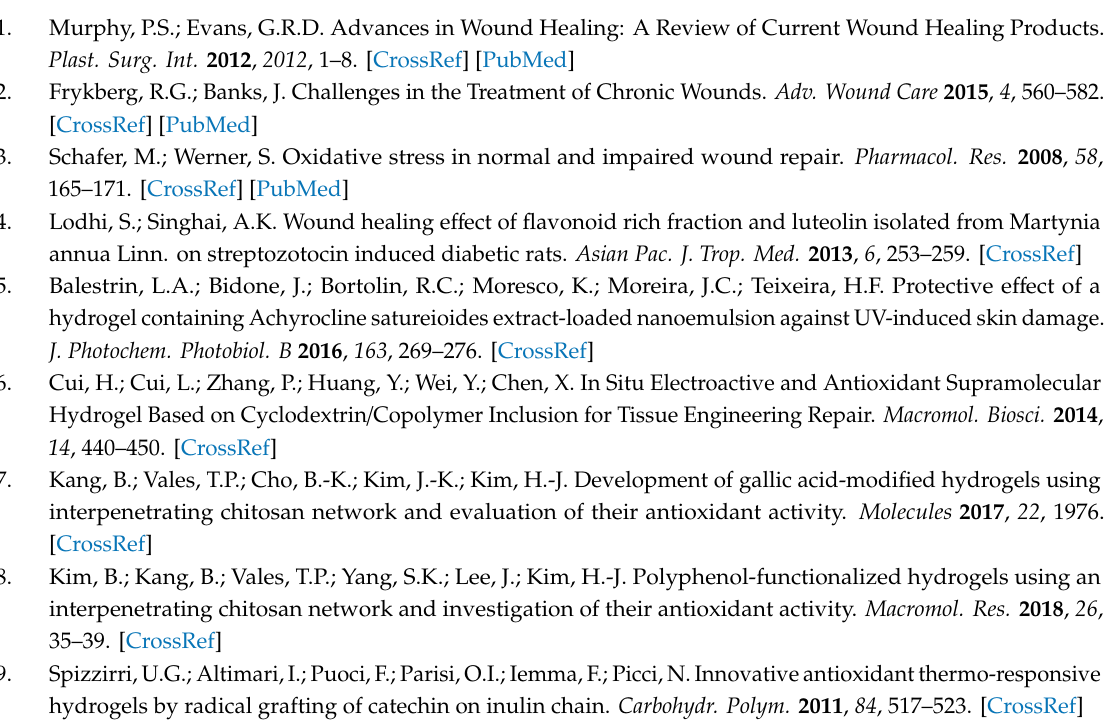
Figure S1: Representative image of hydrogels with feed ratios of dextran:dopamine ranging 2:1–2:0.2, Figure S2: H&E stain of transverse section of human abdominal skin explants showing an untreated wound